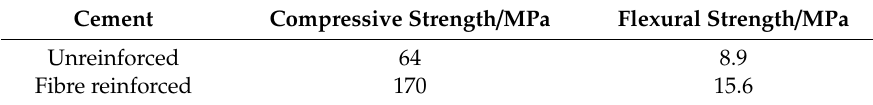
Table 3. E ff ect of 20 volume % reactive glass fibres in the strength of glass-ionomer cement. Cement